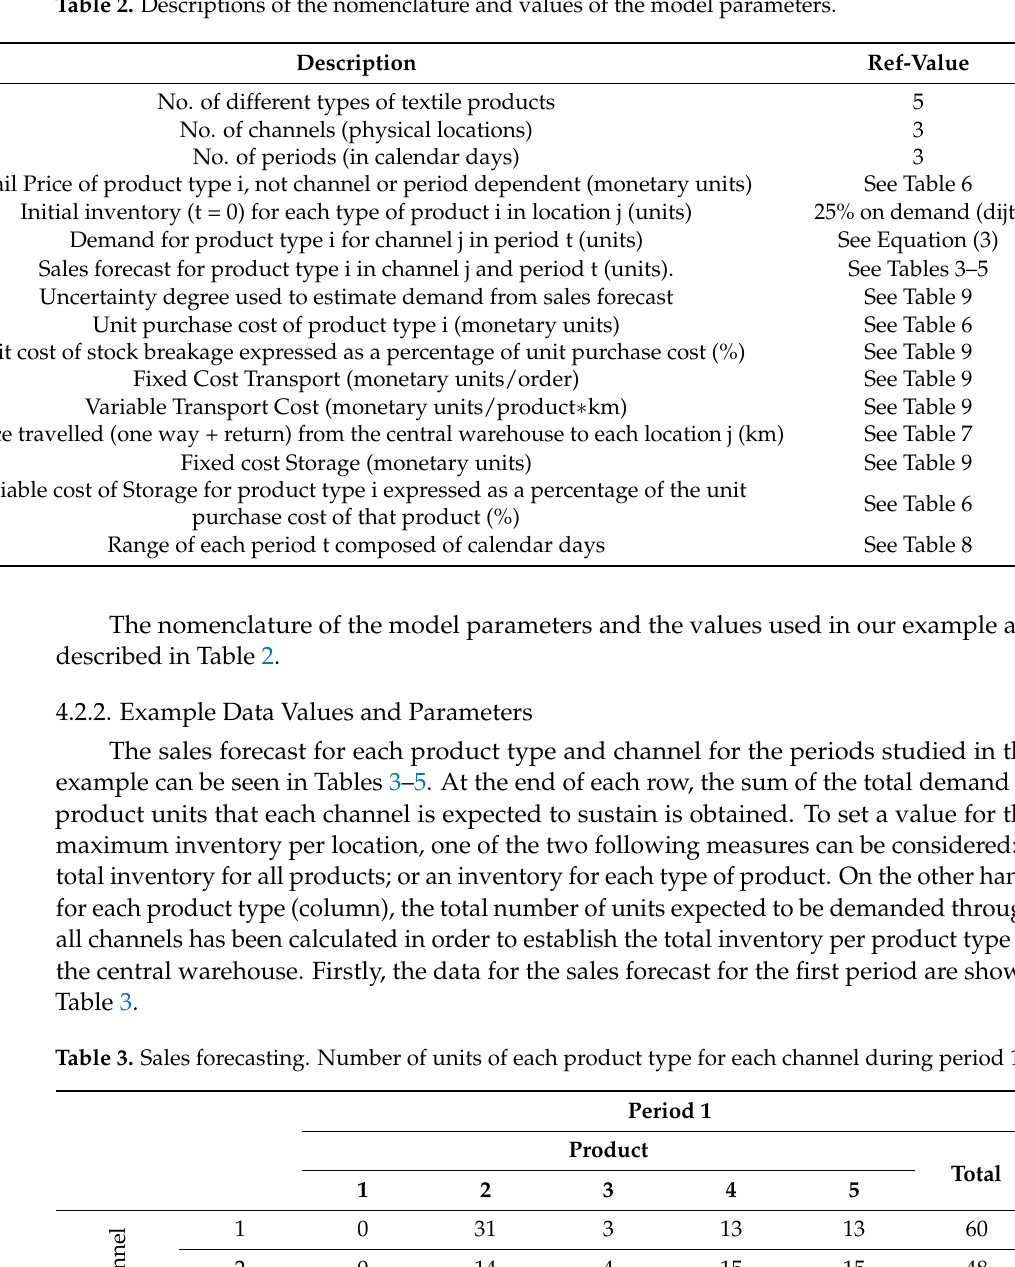
Table 2. Descriptions of the nomenclature and values of the model parameters.